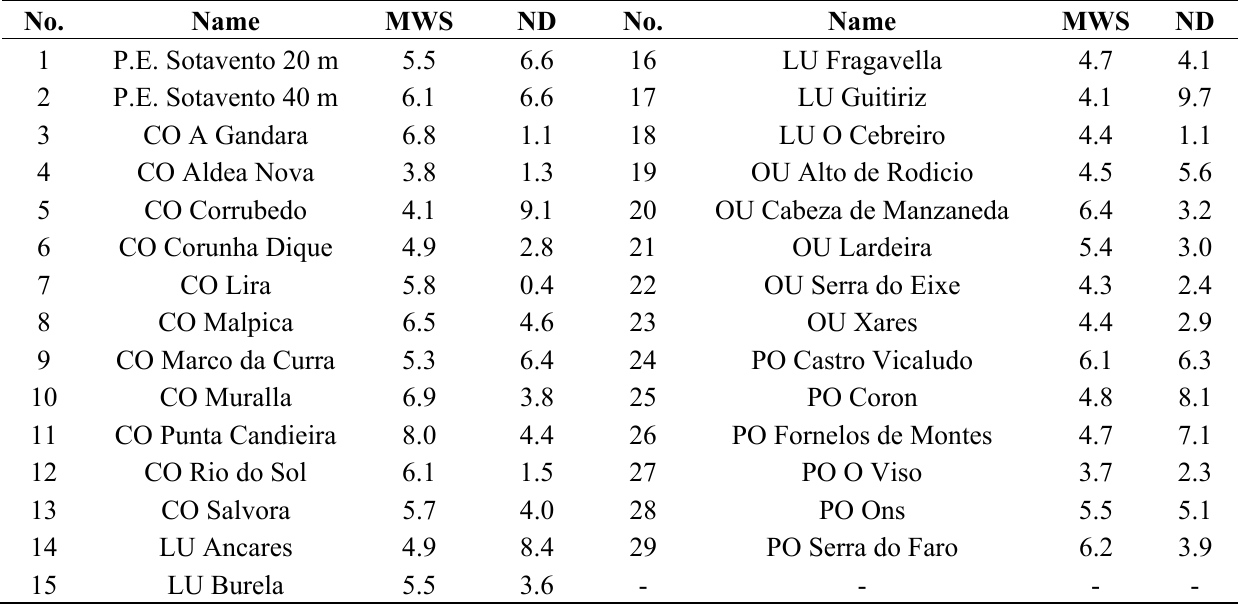
Table 1. Meteorological stations (No.: wind site number; MWS: mean wind speed in m/s; and ND: amount of data in years).